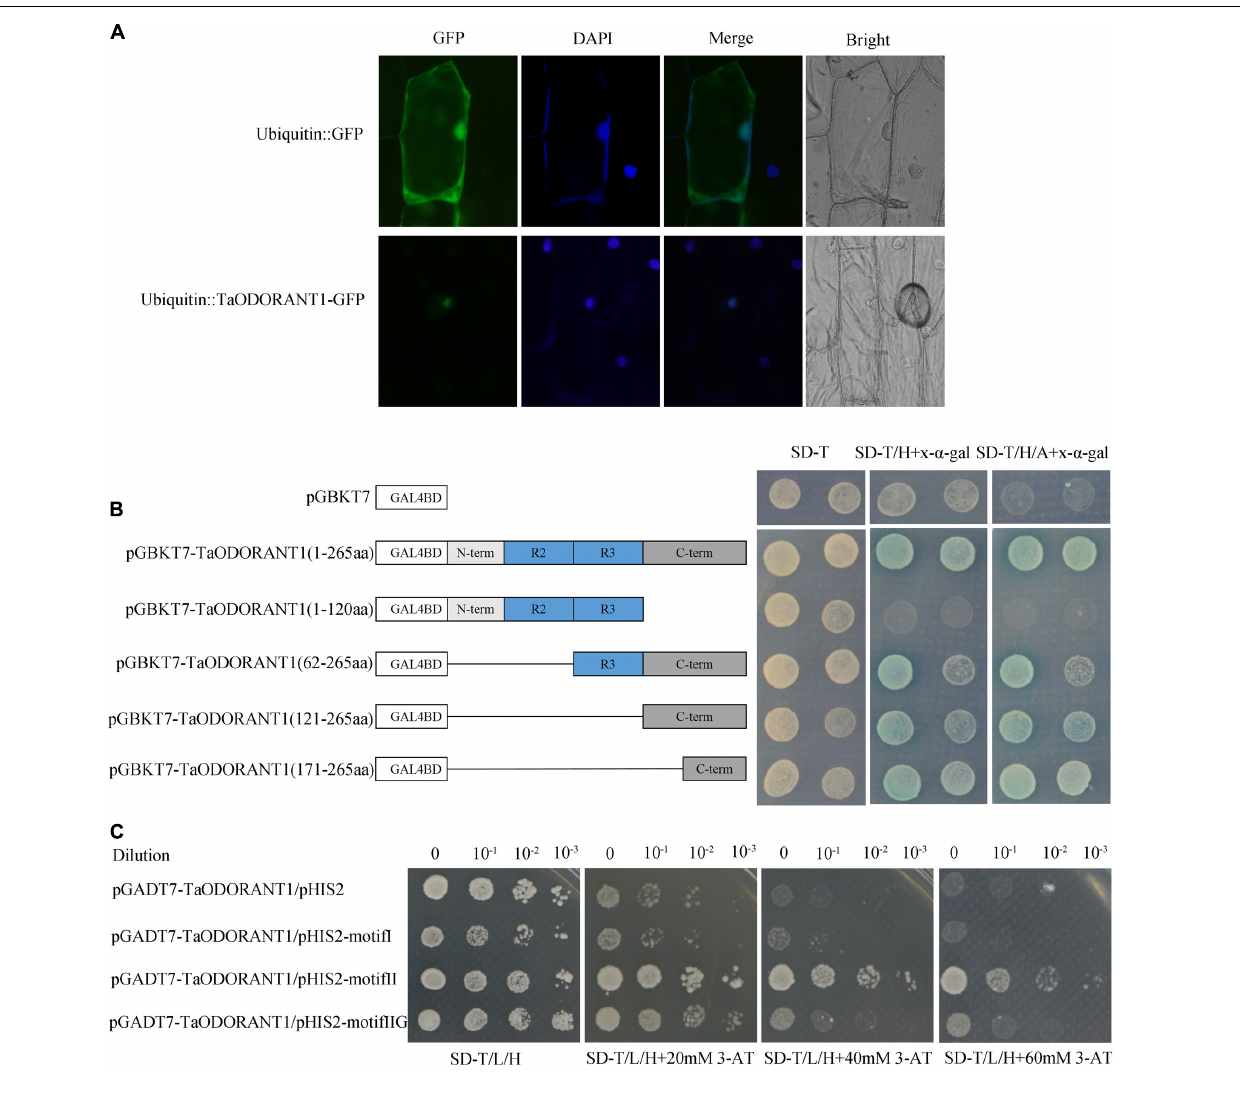
FIGURE 2 | Subcellular localization and transcriptional activity analysis of TaODORANT1. (A) Subcellular localization of TaODORANT1. Recombinant vector ubiqutin::TaODORANT1-GFP and control vector ubiquitin::GFP were transformed into onion epidermal cells and observed with fluorescence microscopy, respectively. (B) Transactivation activity of TaODORANT1 in yeast. Schematic diagrams illustrate the different portions of TaODORANT1 ORF that were introduced into the pGBKT7. Recombined vectors were transformed into yeast strain AH109, and the transformants were screened by SD/-Trp, SD/-Trp/-His+X- α